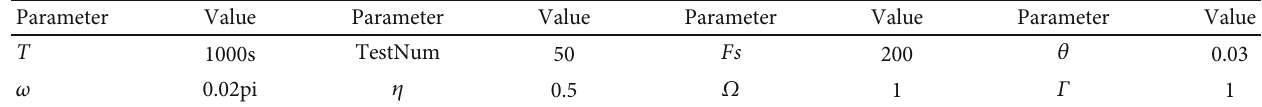
Table 1: The common parameters for numerical simulation of Section 3.